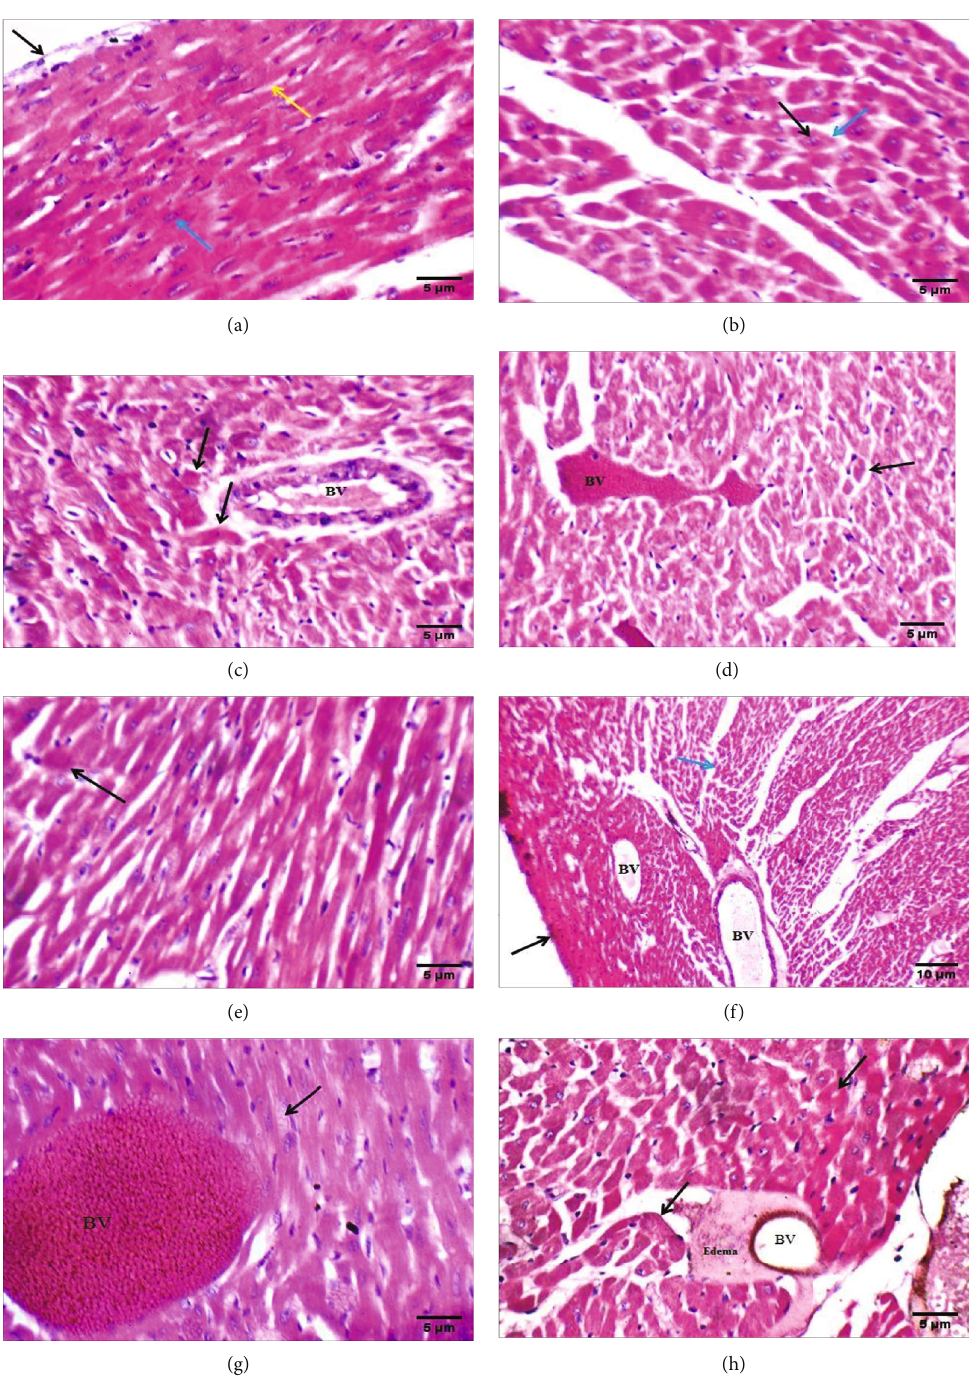
Figure 5: The e ff ects of fi g with olive oil and date palm fruit extracts (FOD) on the microscopic histological appearance of heart tissues treated with di ff erent nanoparticles (NPs) for 75 days. (a) High power view showing intact pericardium (black arrow), viable cardiac muscle fi bers with central oval/elongated nuclei (blue arrow), and distinct cell borders (yellow arrow); (b) FOD-treated group showing viable cardiac muscle fi bers with central elongated nuclei (black arrow) and distinct cell borders (blue arrow); (c) SiO (anucleated) cardiac muscle fi bers (black arrow) and average myocardial blood vessels (BV); (d) FOD-SiO scattered apoptotic (anucleated) cardiac muscle fi bers (black arrow) and mildly dilated congested myocardial blood vessels (BV); (e) Al NP-treated group showing scattered apoptotic (anucleated) cardiac muscle fi bers (black arrow); (f) FOD-Al cardiac wall showing intact pericardium (black arrow), viable cardiac muscle fi bers (blue arrow), and mildly dilated congested blood vessels (BV); (g) ZnO NP-treated group showing cardiac muscle fi bers with scattered intracytoplasmic inclusions (black arrow) and markedly dilated and thrombosed myocardial blood vessels (BV); (h) FOD-ZnO NP-treated group showing few scattered apoptotic (anucleated) cardiac muscle fi bers (black arrow) and mildly dilated blood vessels (BV) with mild perivascular edema